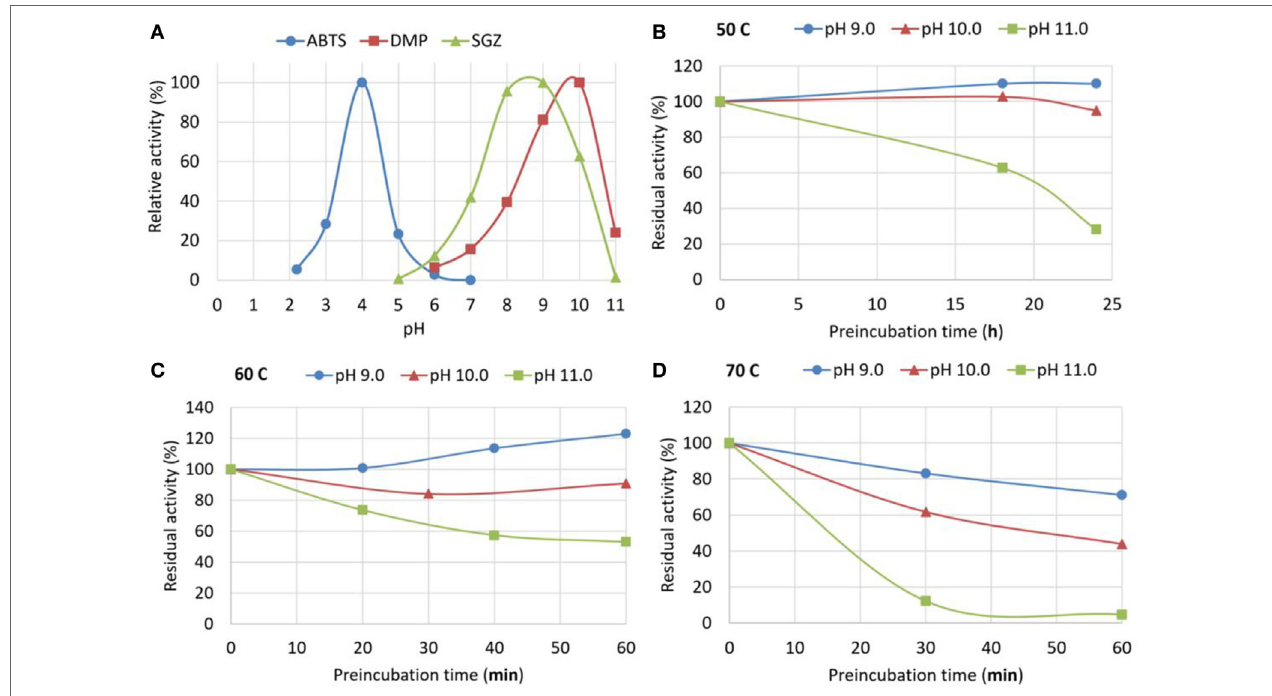
FigUre 1 | Standard activity and stability of MetZyme ® LIGNO ™ . (a) pH dependence of MetZyme ® LIGNO ™ activity toward standard low-molecular weight substrates: 2,2 ′ -Azino-bis(3-ethylbenzthiazoline-6-sulfonic acid) (ABTS), syringaldazine (SGZ), and 2,6-dimethylphenol (DMP). (B–D) Stability of MetZyme ® LIGNO ™ at various pH (9–11) and temperatures (50, 60, and 70°C); pre-incubation time at indicated conditions is plotted against residual activity measured after pre- incubation. Pre-incubation at 50°C was carried out over a span of 24 h, at 60 and 70°C—over 1 h; temperatures and pH are indicated over the graphs. The curves do not represent a model fit, they are line interpolations that Microsoft excel provides as a default and they are added only for